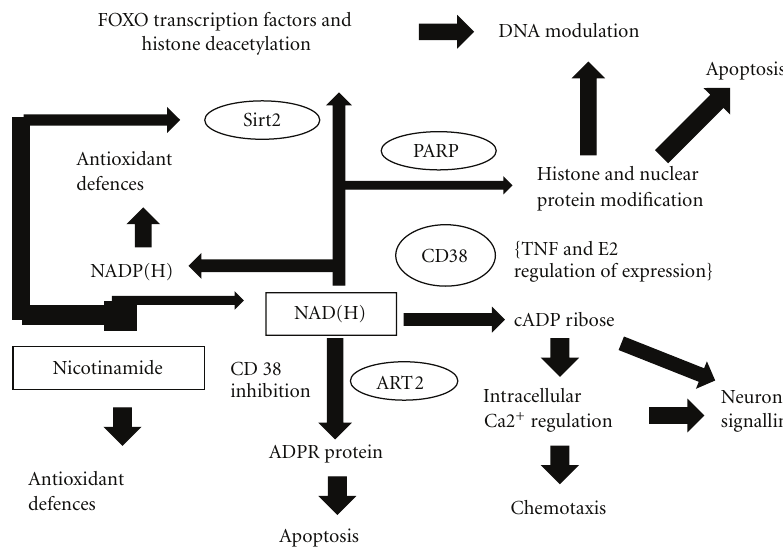
Figure 2: Direct redox regulation apart NAD-consuming pathways influences a prodigious number of pathways involved in internal metabolism and connections with the external world. Survival at the cellular level and of viable interactions with each other and diet and symbionts means that NAD and Nicotinamide are at the hub of the survival of superorganisms such as ourselves. Key: FoxO—forkhead transcription factors; Sirt2 and PARP in text; CD38 cluster di ff erentiation 38; TNF—tumor necrosis factor; E2 Prostaglandin E2; cADP— cyclic adenosine di-phosphate; ART2—T-cell ADPribosyltransferase; ADPR protein—adenosine di-phosphate ribose